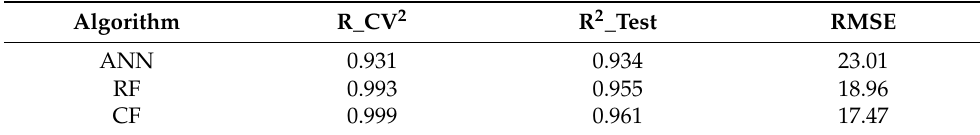
Table 3. Comparison results of different